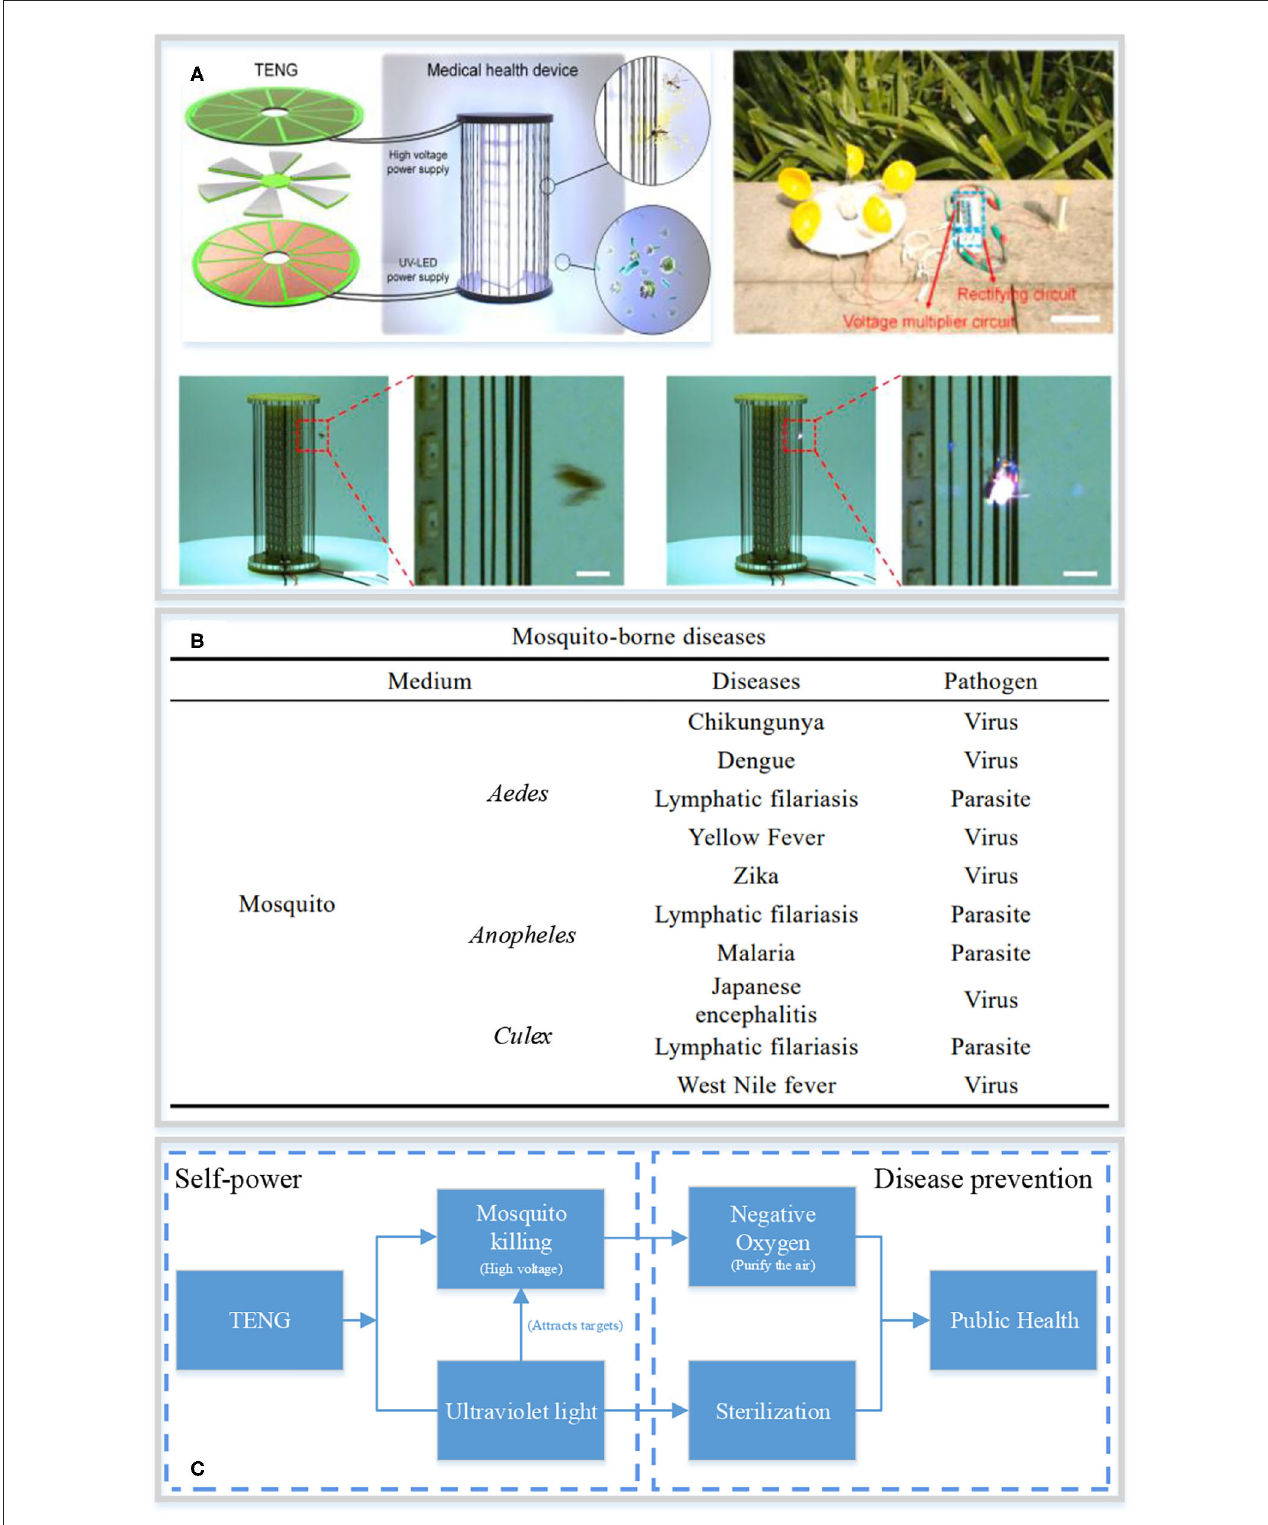
FIGURE1 The new paradigm of mosquito-borne disease control. (A) Structural design and photographs of the TENG-based self-powered sterilization and infection control system (28). (B) Mosquito-borne diseases. (C) Strategy for mosquito-borne disease prevention based on self-powered supply.